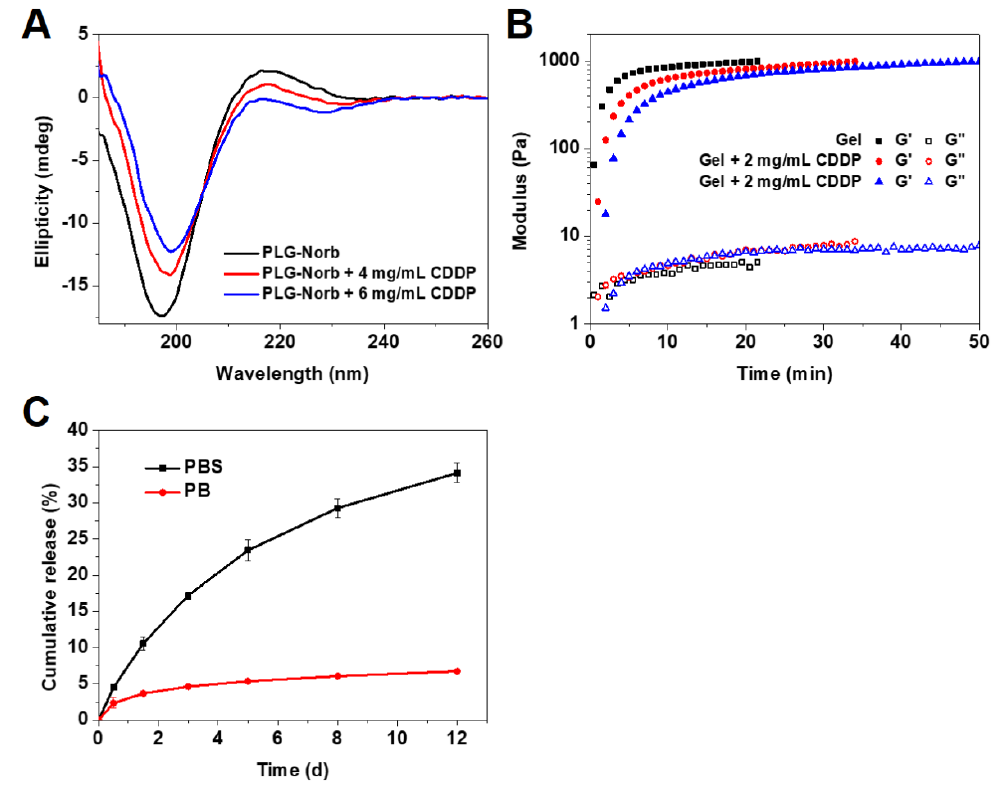
Figure 3. ( A ) CD spectra at the polymer concentration of 0.01 mg / mL in 5 mM PB (pH 7.4). ( B ) Gelation kinetics of cisplatin (CDDP)-loaded hydrogels with CDDP concentrations of 2 and 3 mg / mL. ( C ) In vitro release profiles of CDDP from the hydrogels in PBS or PB (without NaCl).